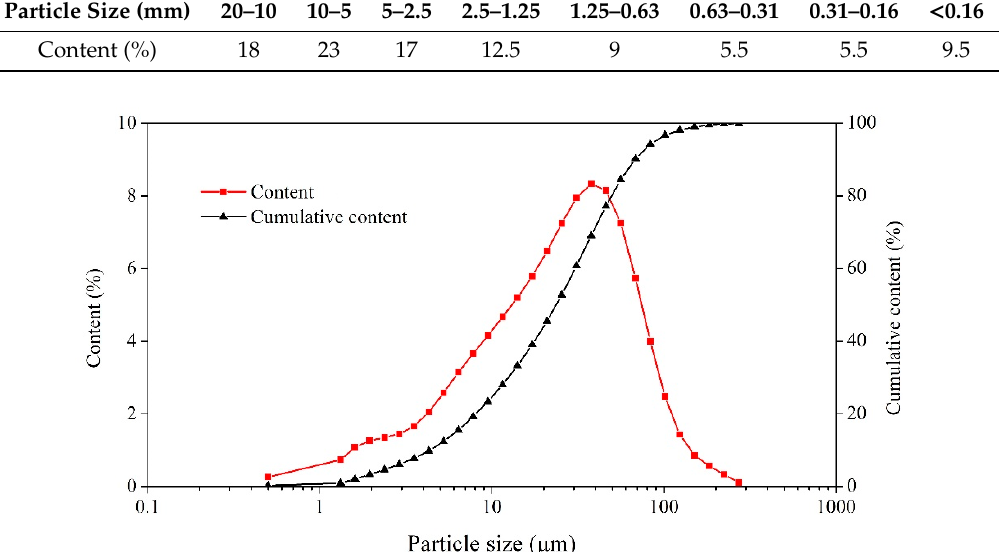
Table 1. Granular composition of coal gangue.